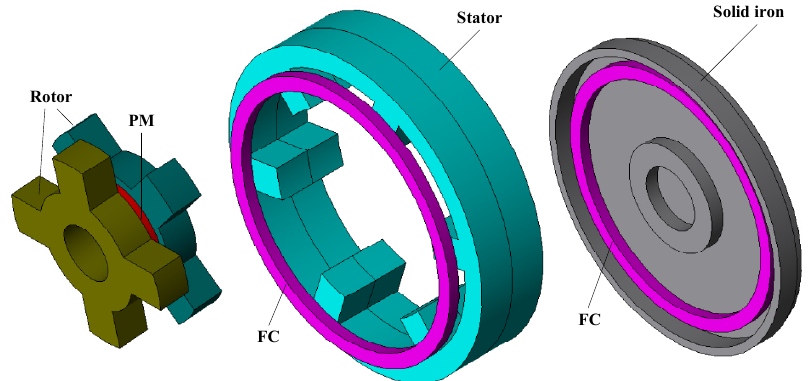
Figure 5. Configuration of the mixed ‐ excited HE machine with skewed dual ‐ stack rotor [34].